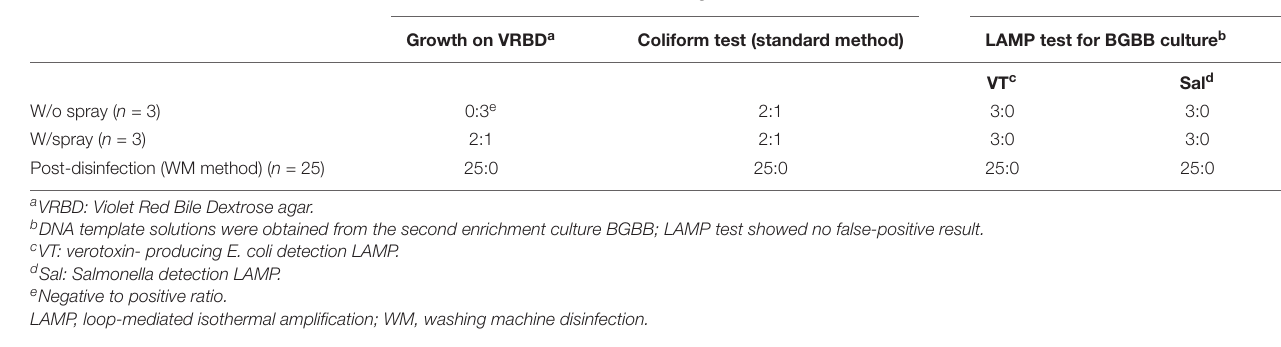
TABLE 5 | Summary of spray method and WM method synergistic effect on the beef without artificial contamination. Standard microbiological